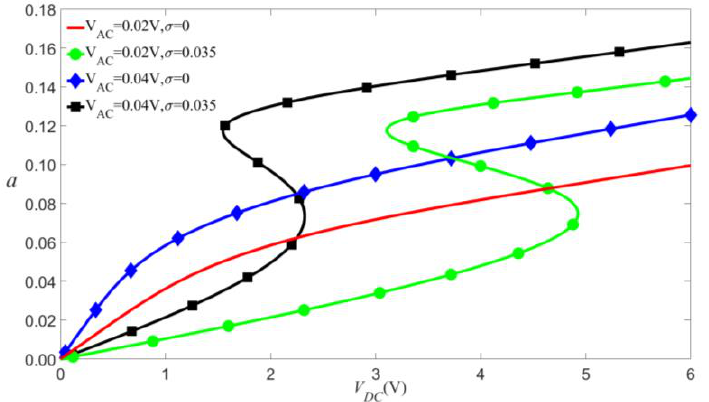
Figure 15. Frequency-response curves of primary resonance for V DC = 4 V.